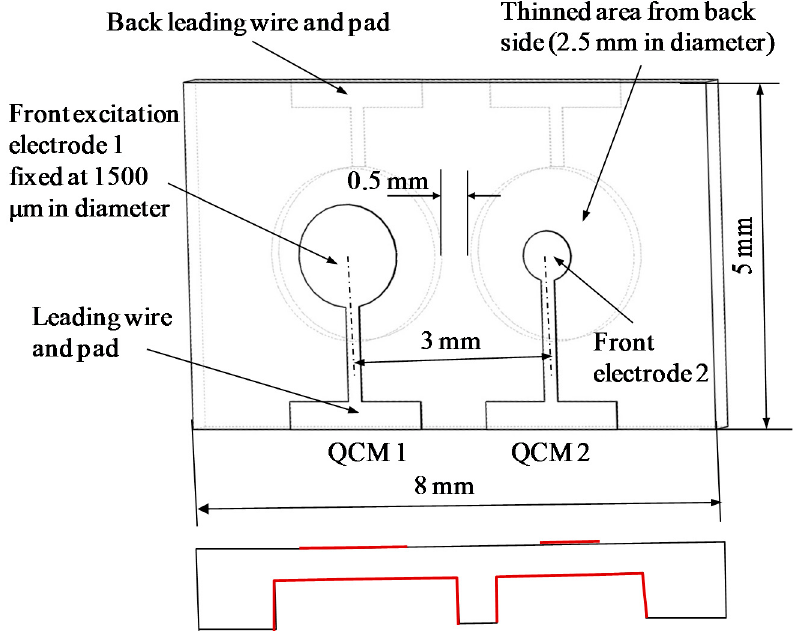
Figure 1. Schematic diagram of the dual-channel QCM configuration.